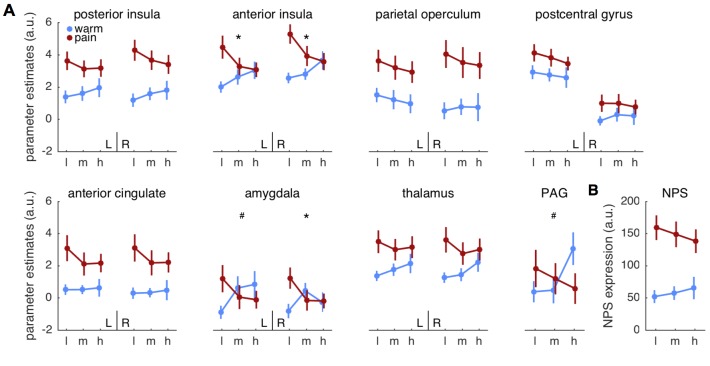
Parameter estimates for regions of interest.(A) Mean parameter estimates (± standard error) are plotted for left (L) and right (R) hemispheres in each panel, except for the midline structure PAG. Blue indicates warm stimuli, red indicates painful stimuli. Cues are on the x-axis, with ‘l’ designating low, ‘m’ designating medium, and ‘h’ designating high probability of pain. PAG = periaqueductal gray. (B) Pattern expression for the neurological pain signature (NPS; Wager et al., 2013). *interaction effect significant FDR corrected q < 0.05. #interaction: p<0.05, uncorrected.